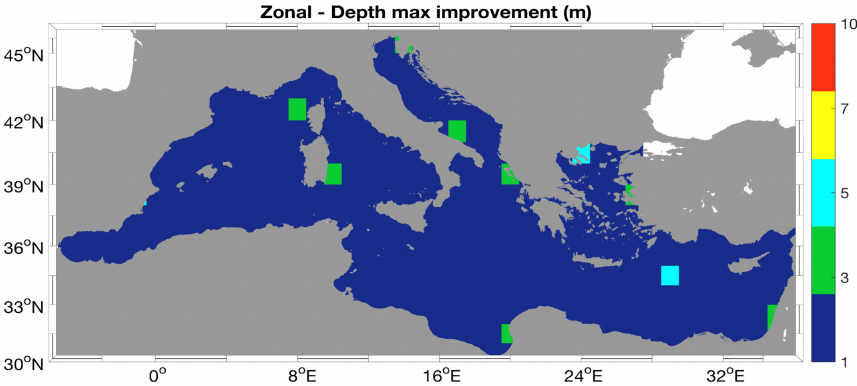
Figure 13. Depth of maximum OPC PI over the year 2017, represented in 1 ◦ × 1 ◦